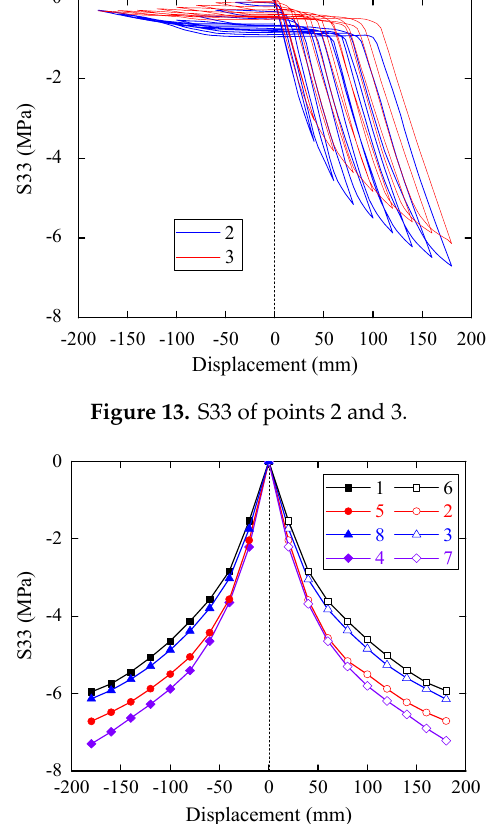
Figure 14. Envelope curves of S33.